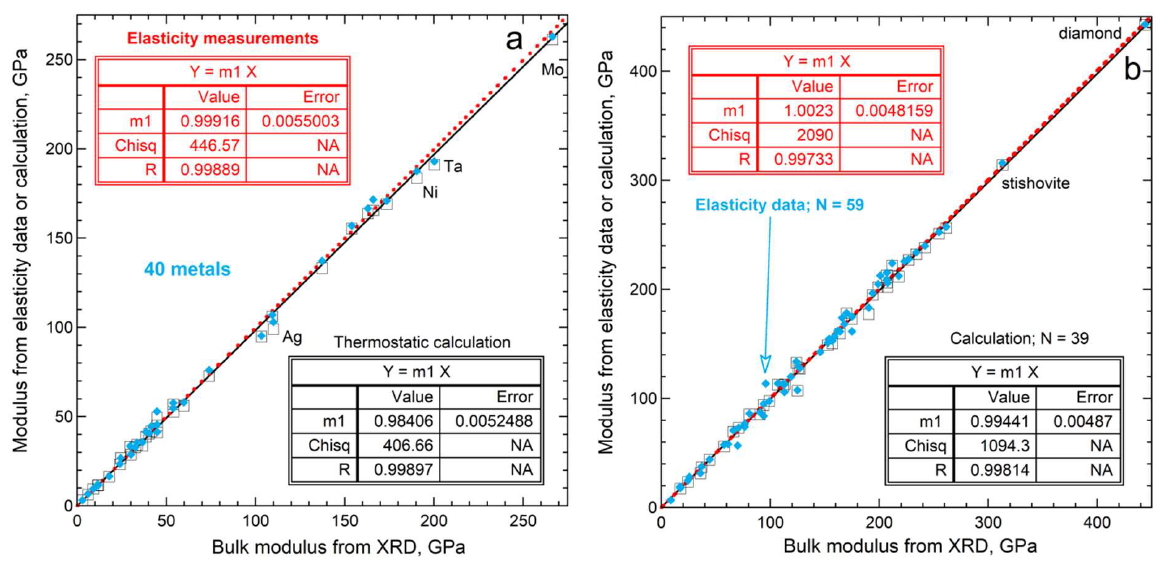
Figure 5. Comparison of data on bulk modulus from compilations of data from different experimental techniques. The x-axes depict XRD results from [32]: ( a ) metallic elements. Elasticity data (color points and line) mostly from [36]; supplemented by data on Pb and In [38] and Zn [35]. Calculations use γ th from [36]; recommended values of α from [37]; and c P from [39]; ( b ) electrical insulators and the non-metallic elements Si and C. Elasticity data on Si from [40]: otherwise from [41].